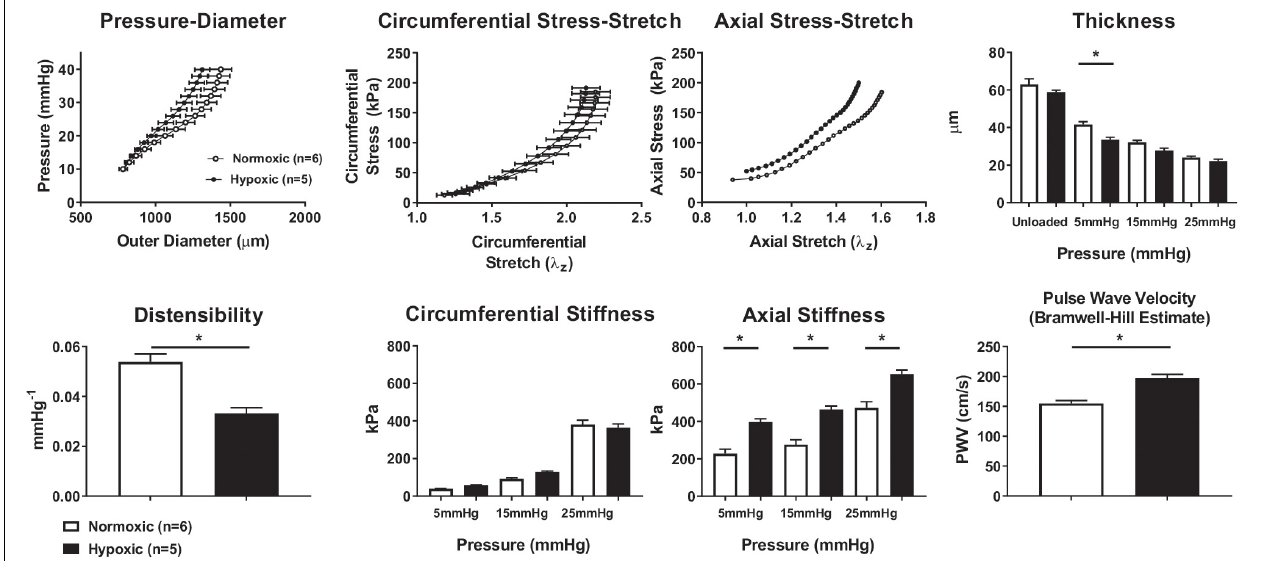
FIGURE 2 | Mechanical properties of normoxic and hypoxic mouse pulmonary arteries. (Top row) Data collected (pressure, arterial diameter, stretch) or calculated (stress) from cannulated normoxic ( n = 6) and hypoxic ( n = 5) right pulmonary arteries of C57BL6J mice using a computer-controlled testing device. Pressure-diameter measurements were at vessel-specific optimized axial stretch (mean ± SEM). Stress-stretch measurements were taken with the vessel at 15 mmHg. Wall thickness measurements for normoxic ( n = 6) and hypoxic ( n = 5) right pulmonary artery vessels at various pressures. Unloaded (zero mmHg intraluminal pressure) wall thickness was measured by histologic analysis and MatLab. Loaded (5, 15, 25 mmHg) wall thickness measurements were calculated based on mechanical measurements. Despite some differences at individual pressures, there is no overall difference in thickness of normoxic and hypoxic vessels. (Bottom row) Mechanical properties calculated from mechanical testing and fit to the four-fiber constitutive relation, including distensibility, circumferential stiffness, axial stiffness, and PWV. There is a significant decrease in distensibility observed in hypoxic vessels. The circumferential stiffness of hypoxic and normoxic pulmonary arteries is similar at lower pressures; however, at 25 mmHg, the circumferential wall stress in hypoxic pulmonary arteries tends to decrease. The axial stiffness calculated for hypoxic vessels is greater than normoxic vessels at diastolic, mean, or systolic pressures (5, 15, 25 mmHg, respectively). The changes in structural and mechanical properties of the arterial wall and distensibility due to hypoxic exposure result in a significant increase ( p < 0.05) in PWV of the right pulmonary artery of mice at 15 mmHg. * p <